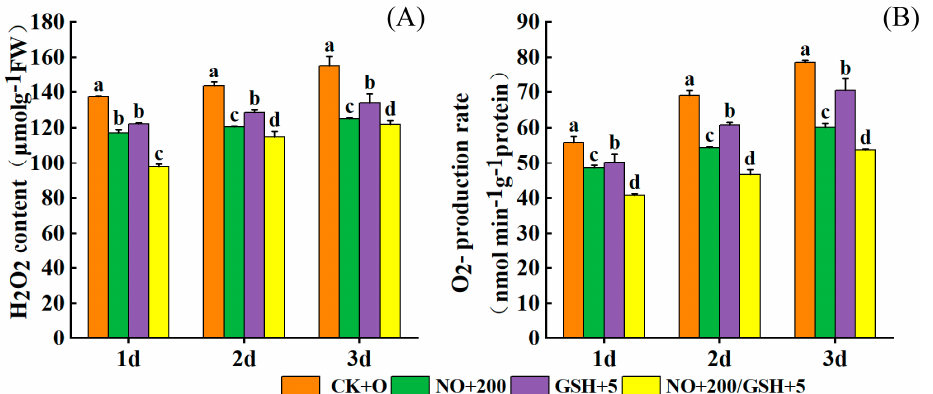
Figure 2. Effects of NO and GSH on H 2 O 2 ( A ) and O 2 − ( B ) of cowpea seedlings under low- temperature stress. Each value is presented as the mean ± standard error (n = 3). The differences among the treatments indicated with the same letter vertically were not significant according to Duncan’s multiple range test at p < 0.05.